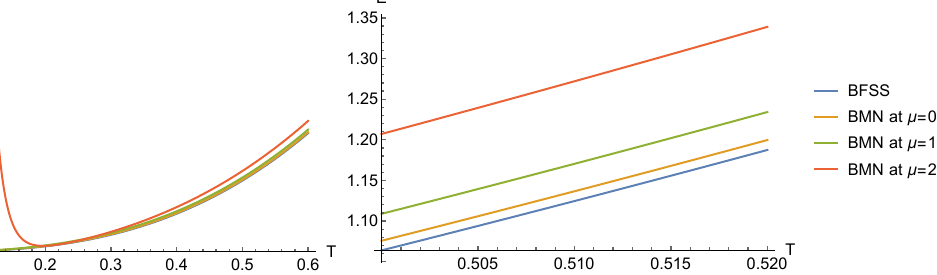
Figure 3 . f (ˆ µ ) and s (ˆ µ ) from [19].